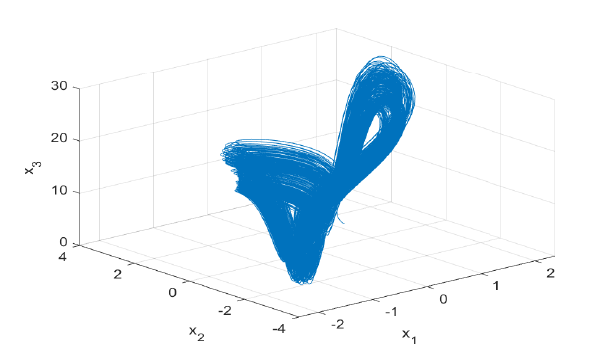
Figure 9. Phase portraits of system (1) for a = 10, c = 8/3, d = 0.1, and b = 4.